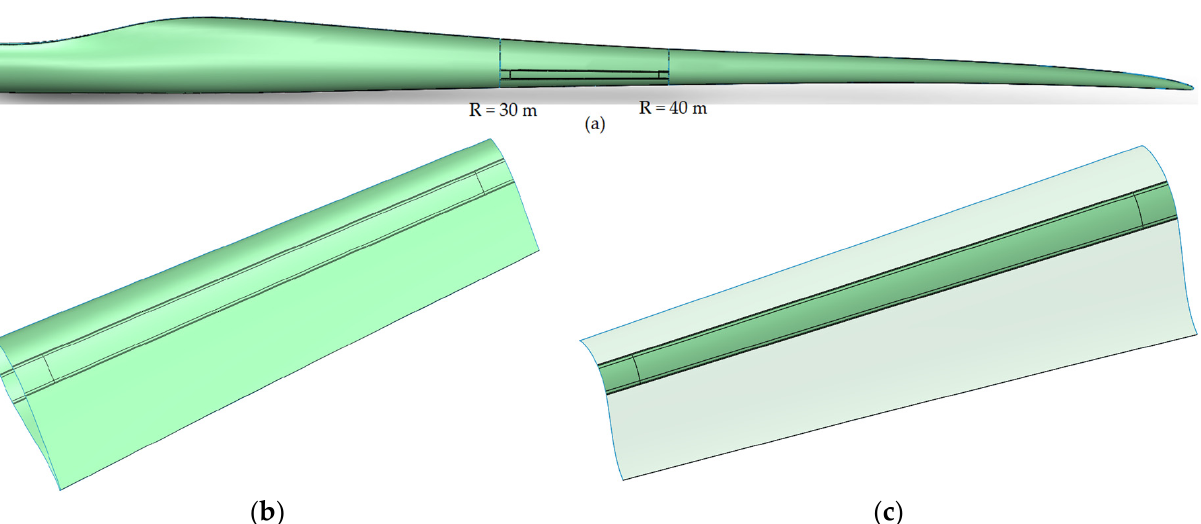
Figure 4. The repair length of 3D blade: ( a ) repair length of 30–40 m; ( b ) repaired cross-section; ( c ) repaired spar cap.